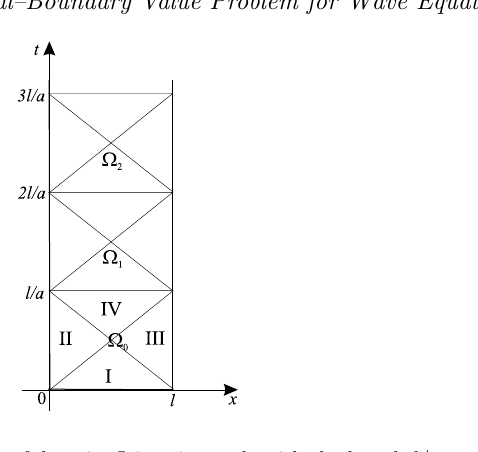
Figure 3. Division of domain Ω into intervals with the length l/a